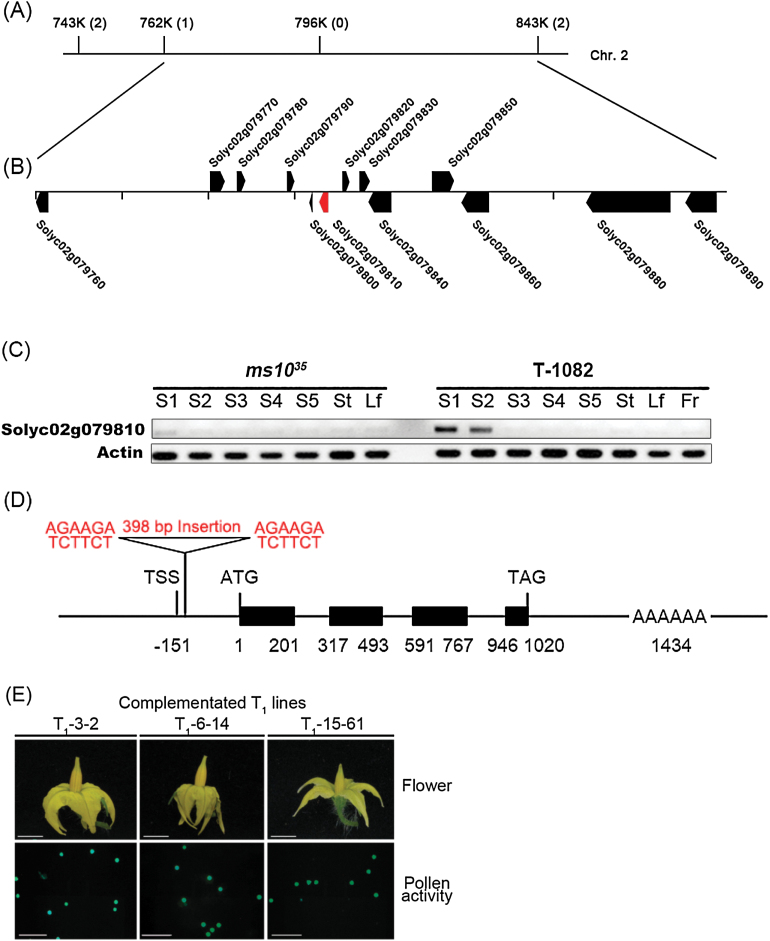
Map-based cloning of the Ms10
35 gene. (A) Fine genetic mapping of the Ms10
35 gene delimited the target gene within an interval between markers 762K and 843K on chromosome 2. Numbers in parentheses indicate the number of recombination events identified between the markers and the target gene. (B) Physical map of the region containing the Ms10
35 gene. Pentagons indicate predicted genes and their directions. The putative Ms10
35 gene (Solyc02g079810) is indicated in red. Solyc02g079760, bHLH transcription factor; Solyc02g079770, DAG protein; Solyc02g079780, glycine-rich protein; Solyc02g079790, DUF538; Solyc02g079800, unknown protein; Solyc02g079810, putative Ms10
35 gene; Solyc02g079820, pentatricopeptide repeat-containing protein; Solyc02g079830, pentatricopeptide repeat-containing protein; Solyc02g079840, terpene synthase; Solyc02g079850, pleckstrin homology; Solyc02g079860, NPH3; Solyc02g079880, translation initiation factor; Solyc02g079890, terpene synthase. (C) RT-PCR for Solyc02g079810 from ms10
35 and T-1082 plants. S1–S5, different stages of anther development (S1, meiosis and tetrad stage; S2, young and vacuolated microspore stage; S3, mitosis and maturation stage; S4, dehiscence stage; S5, opened flower stage); St, stem; Lf, leaf; Fr, fruit. Actin was used as a loading control. (D) The structure of the Ms10
35 gene encoding a bHLH transcription factor. Black boxes indicate exons. The ATG start site is denoted as position 1 and the other numbers indicate nucleotide distance from the ATG site. A transposon insertion flanked by direct repeat nucleotide sequences (AGAAGA/TCTTCT) was found between the transcription start site (TSS) and the ATG in ms10
35. (E) Flower morphology and pollen viability in ms10
35 transgenic plants complemented with the wild-type Ms10
35 gene. Three independent T1 transgenic plants with the Ms10
35 gene showed normal flowers and had viable pollen. Bars, 0.5cm (flower images); 200 μm (pollen viability images). (This figure is available in colour at JXB online.)